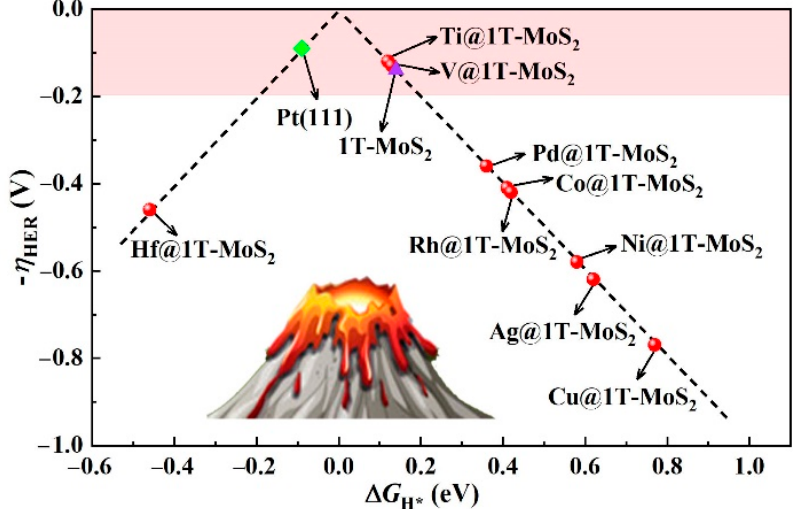
Figure 3. HER volcano plot of TM@1T-MoS 2 compared to Pt(111) and pristine 1T-MoS 2 catalysts. To gain insights into the HER kinetics, we took Ti@1T-MoS 2 as a representative to search for the minimum energy pathway and calculated the reaction barrier through the climbing-image nudged elastic band (NEB) method [40]. As reported in previous work [24], for Pd@1T-MoS 2 catalyst, the H atom is first adsorbed on the activated S atom and then transferred to the proximal Pd atom to generate H 2 (Figure 4a). Surprisingly, for the Ti@1T- MoS 2 catalyst, the first H atom prefers to be directly bonded with the Ti atom anchored on the basal plane, which can effectively boost the efficiency of proton transfer. Then, H* reacts with another adsorbed H* to form H 2 , as displayed in Figure 4b. The obtained results show that the single Ti atom on Ti@1T-MoS 2 is the principal active center for catalyzing hydrogen evolution. The corresponding minimum energy pathway of Volmer step and Tafel H-H recombination is visually presented in Figure 4c. It is clear that for Ti@1T- MoS 2 electrocatalyst, the reaction barrier of Tafel step reduces from 1.15 eV